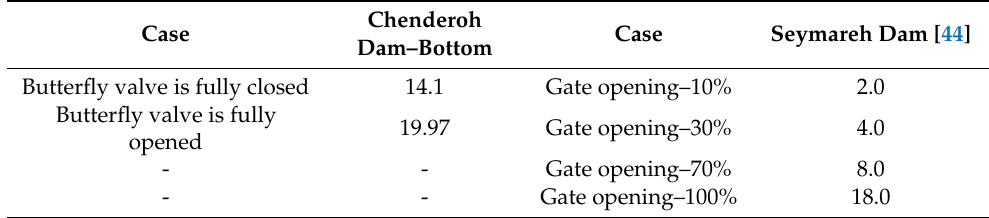
Table 2. Comparison of study conducted with that of Manafpour and Rovesht, 2017. Chenderoh Case Seymareh Dam [44] Case Dam–Bottom Butterfly valve is fully closed 14.1 Butterfly valve is fully